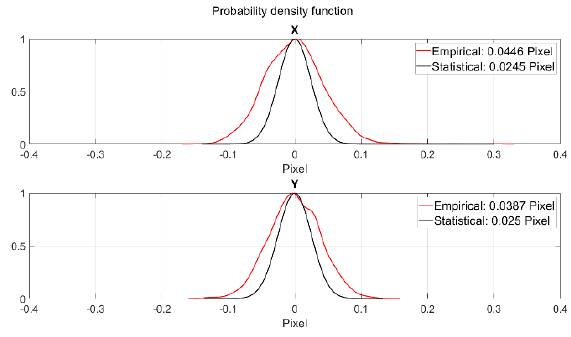
Figure 5 . Figure placement and